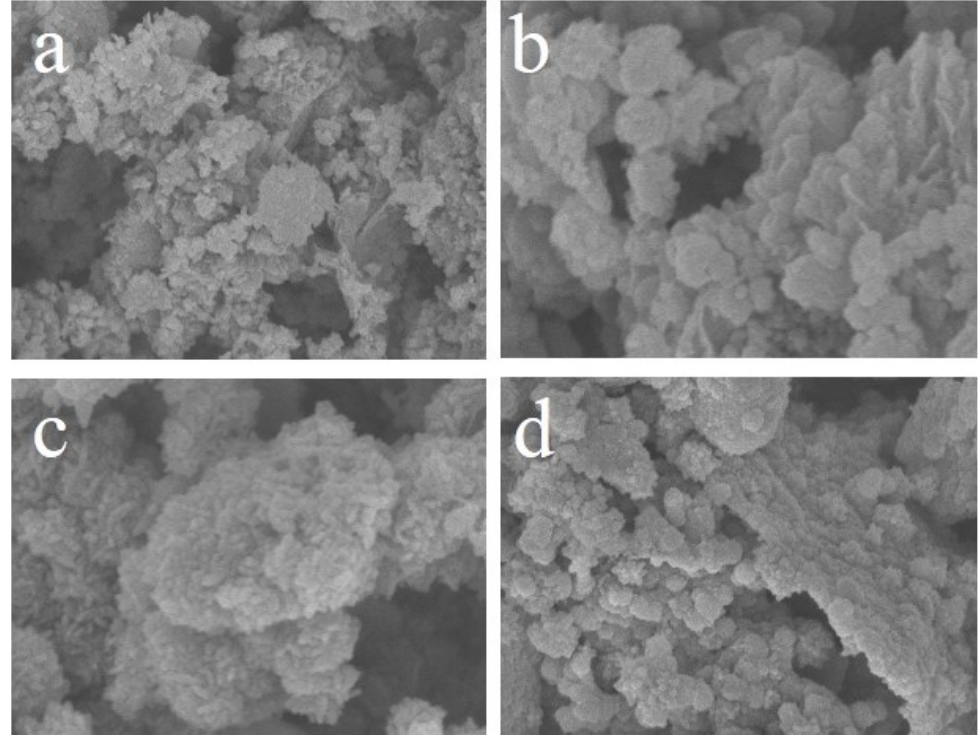
Figure 4. SEM images of ITO-rGO and TiO 2 prepared in different DEG concentrations: ( a ) 3 mol/L, ( b ) 5 mol/L, ( c ) 7 mol/L, and ( d ) 9 mol/L. ( b ) 5 mol / L, ( c ) 7 mol / L, and ( d ) 9 mol /